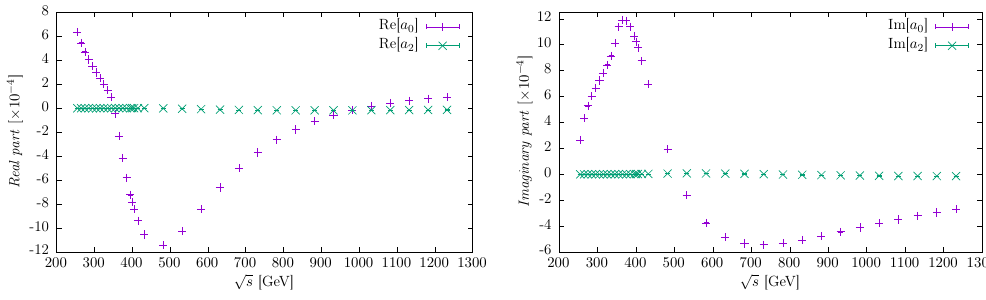
Figure 5 . Fit results: real (left) and imaginary (right) parts of a 0 ( s ) and a 2 ( s